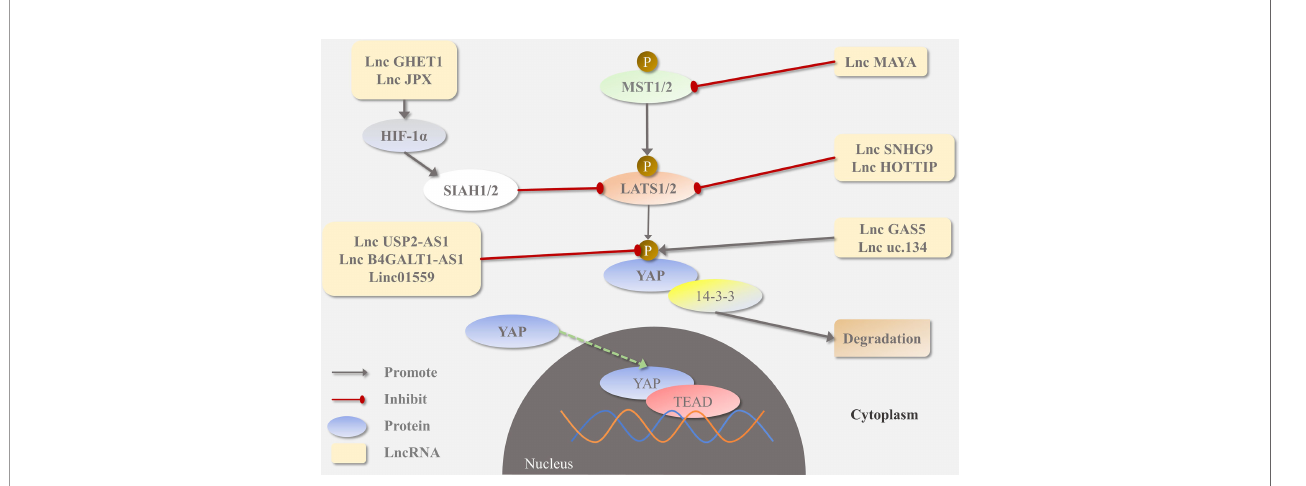
FIGURE 2 | HIPPO-YAP signaling pathway and its regulation by